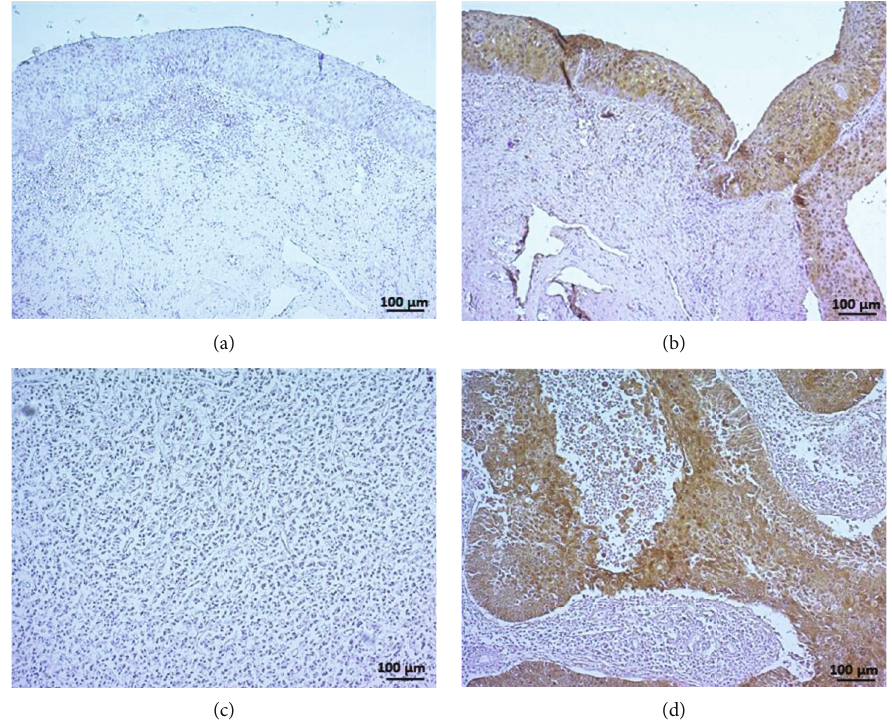
Figure 8: p16 immunohistochemistry. (a) Cervical cancer tissue as a negative control without primary antibody. (b) Cervical cancer tissue as a positive control for p16 staining. (c) Lung cancer tissue negatives for p16 staining. (d) Lung cancer tissue positive for p16